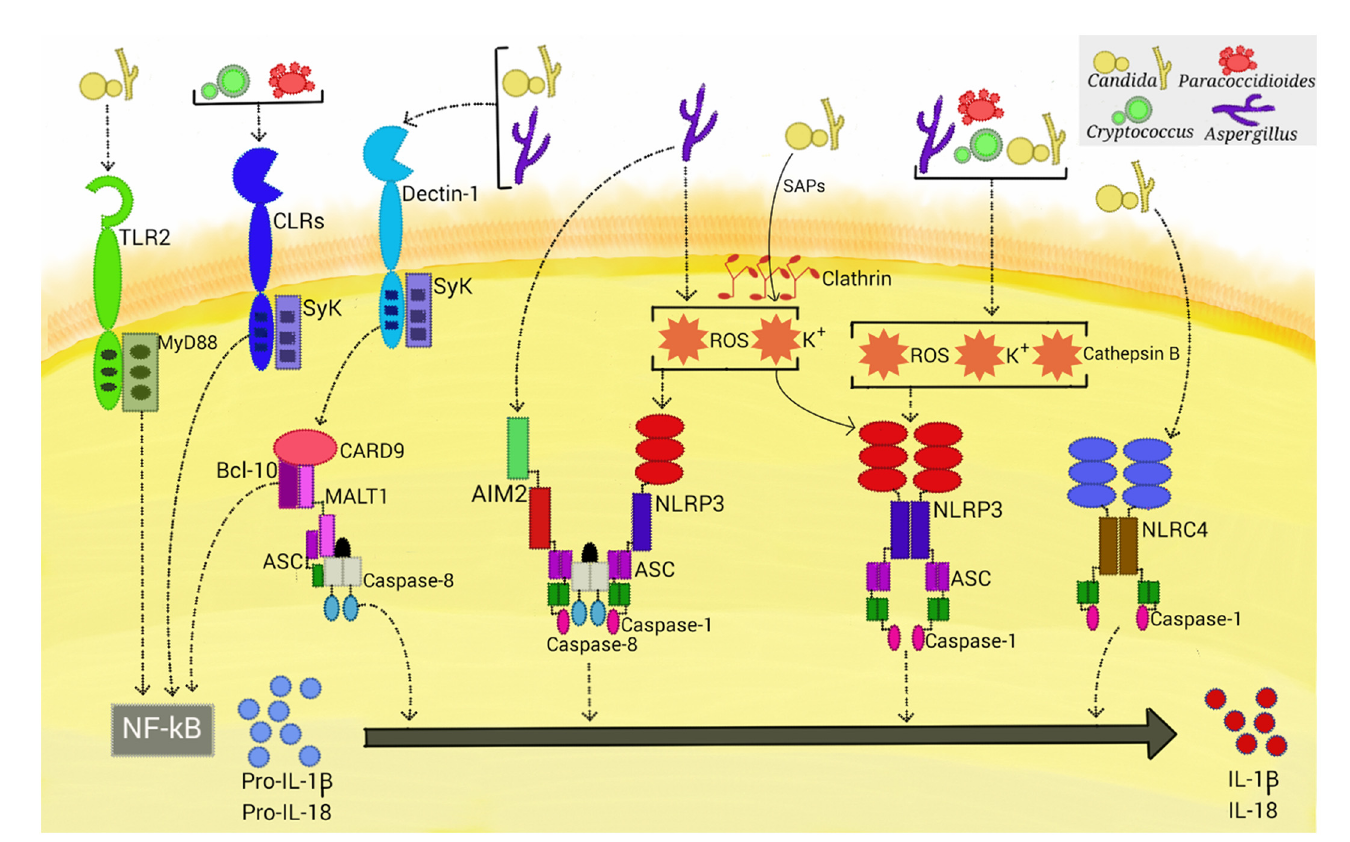
Fig 1. Activation of inflammasomes by fungal pathogens. Four inflammasome complexes are activated when engaged by systemic fungal pathogens. Candida , Aspergillus , Cryptococcus , and Paracoccidioides trigger priming-associated receptors (e.g., dectin-1 and TLR2), thereby promoting the first step (priming) of inflammasome activation. All four pathogens activate the canonical caspase-1-dependent NLRP3 inflammasome by inducing ROS, K + efflux, and cathepsin B release. Candida -secreted aspartic proteases (Saps) are internalized and also activate the NLRP3 inflammasome via induction of K+ efflux and ROS production. Aspergillus activates both caspase-1- and caspase-8-dependent inflammasomes, requiring the simultaneous activation of the NLRP3 and AIM2 receptors. In terms of NLRP3-independent inflammasomes, Candida and Aspergillus activate a caspase-8-dependent inflammasome that requires the engagement of dectin-1, Syk signaling, and ASC recruitment. In addition, Candida triggers the NLRC4